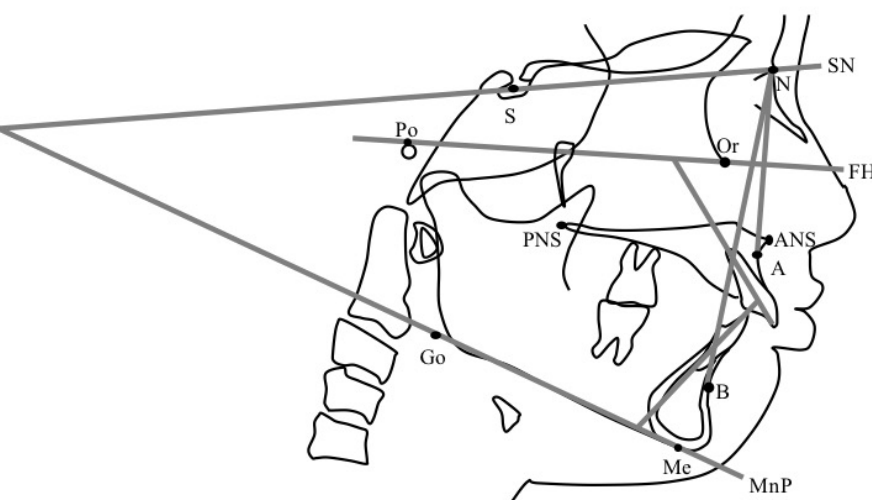
Figure 4. Anatomical angles analyzed in this study. SNA: the angle between the S–N plane and the straight-line N–A. SNB: the angle between the S–N plane and the straight-line N–B. ANB: the angle between the straight-line N–A and N–B. MnP: mandibular plane according to Downs; the plane connecting through Go and Me. FH (Frankfort horizontal) plane: the plane that connects Po and Or. SN/MP: the angle created between the SN plane and the MnP plane. U1 to FH: the angle between the U1 ′ s axis and FH plane. L1 to MnP: the angle between L1 ′ s axis and MnP. Interincisal angle: measures the degree of procumbence of the incisor teeth.